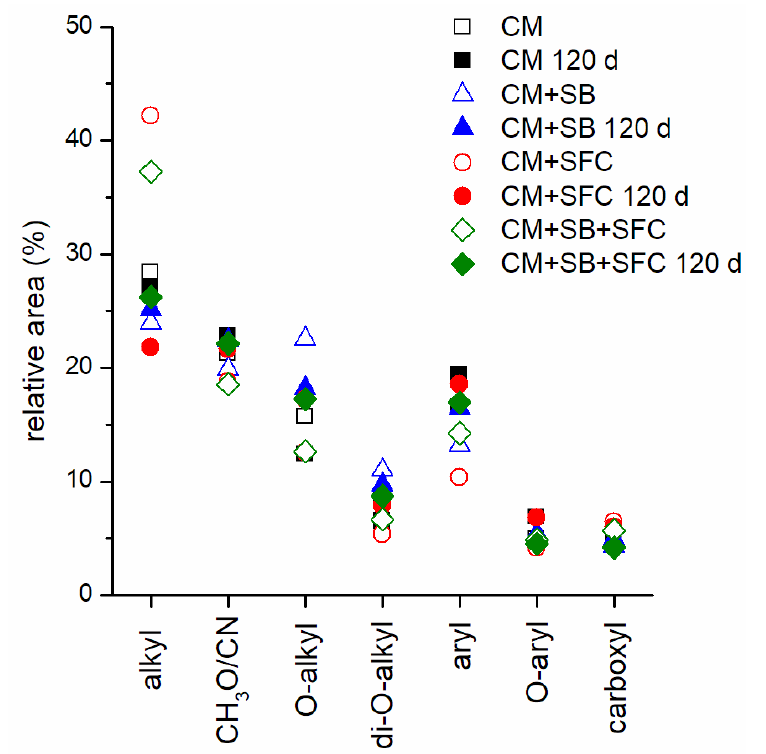
Figure 6. Relative areas of the 13 C NMR spectral regions recorded for HAs extracted from feedstocks (CM, CM+sugar cane bagasse (SB), CM+sunflower cake (SFC), and CM+SB+SFC) and vermicomposts matured for 120 days (Data taken from Ref. [115]).